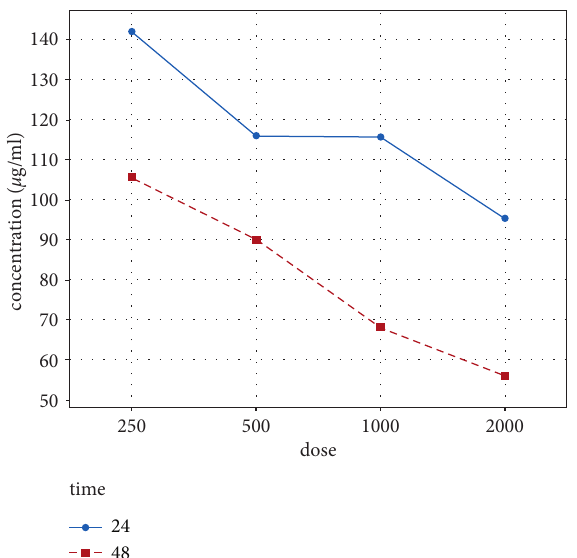
Figure 4: Percent of NHDF cell viability treated with different doses of 2000, 100, 500, and 250 µ g of